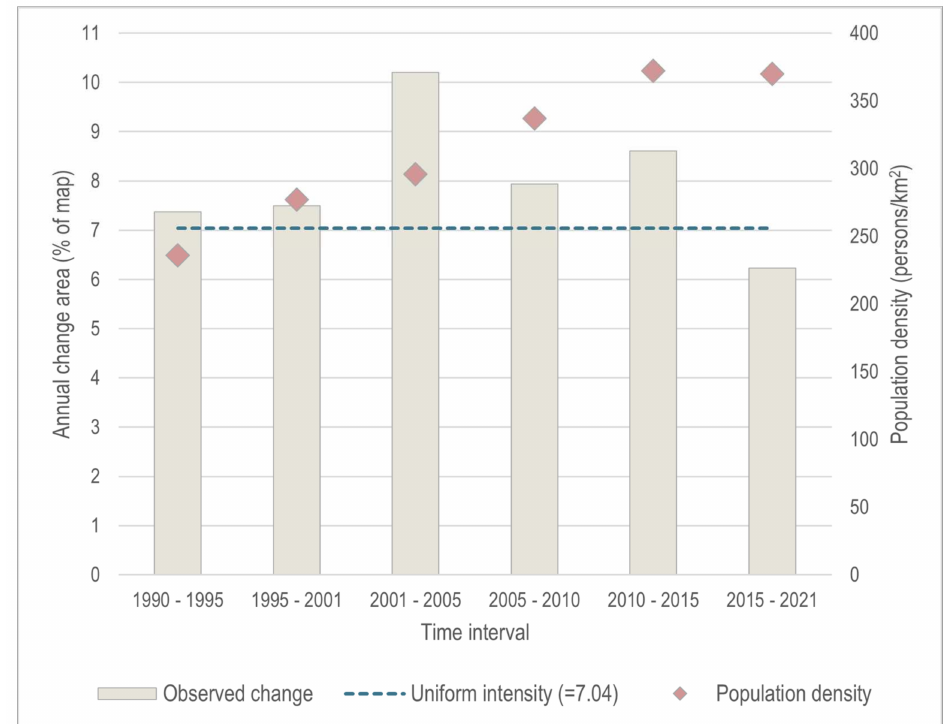
Figure 5. Rate of annual landscape changes in the Ayeyarwady Delta between 1990 and 2021. The uniform intensity line represents the annual rate of change assuming a spatiotemporally equal distribution. Population density as ambient population is taken from corresponding LandScan data for the